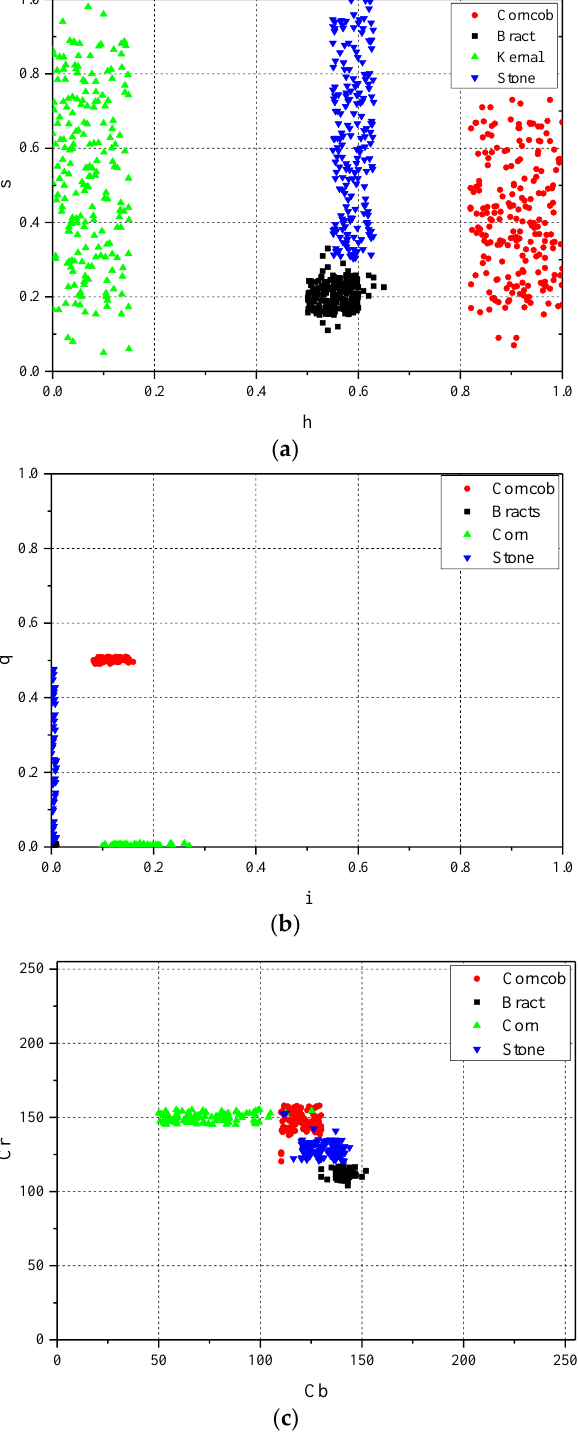
Figure 5. Pixel intensity values of each channel of the image in different colour spaces: ( a ) statistical chart of H and s range in HSV space, ( b ) statistical chart of i and q range in NTSC space, ( c ) statistical chart of Cb and Cr range in YCbCr space.